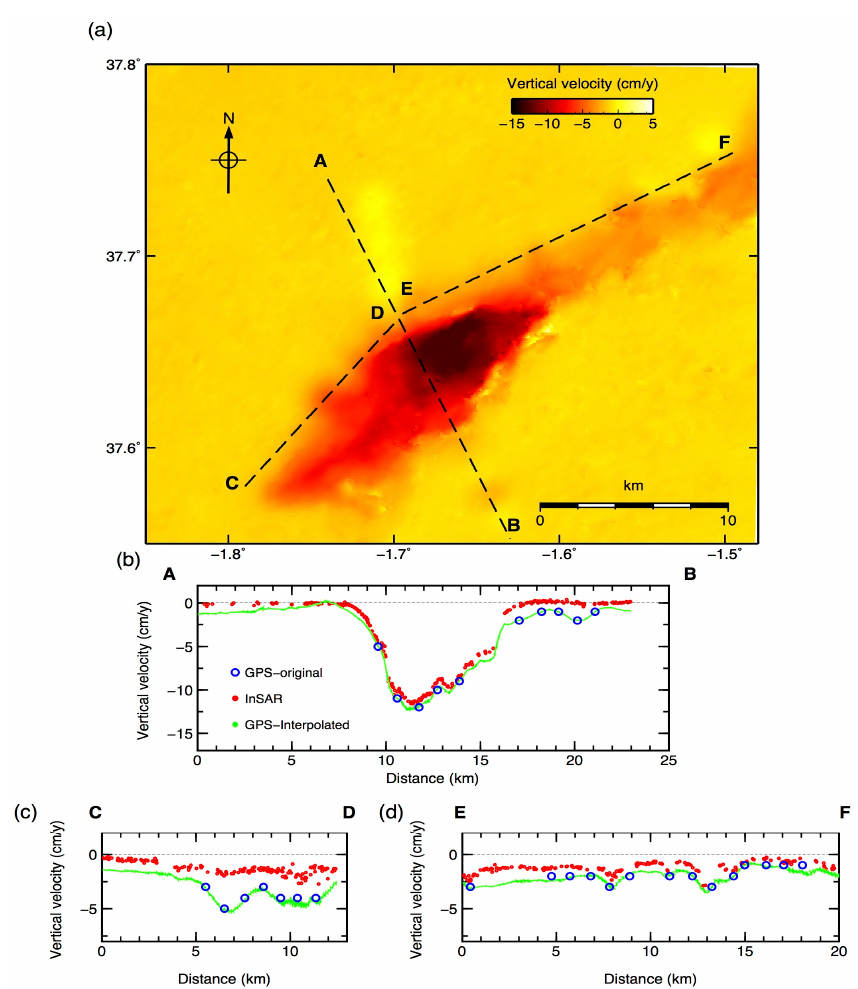
Figure 4. ( a ) Interpolated GPS-velocity map for period 2004–2013. Dashed black lines indicate cross-sections in ( b – d ). ( b – d ) Cross-sections showing vertical ground deformation rates from InSAR (red dots), GPS measurements (blue dots) and GPS interpolations (green dots).